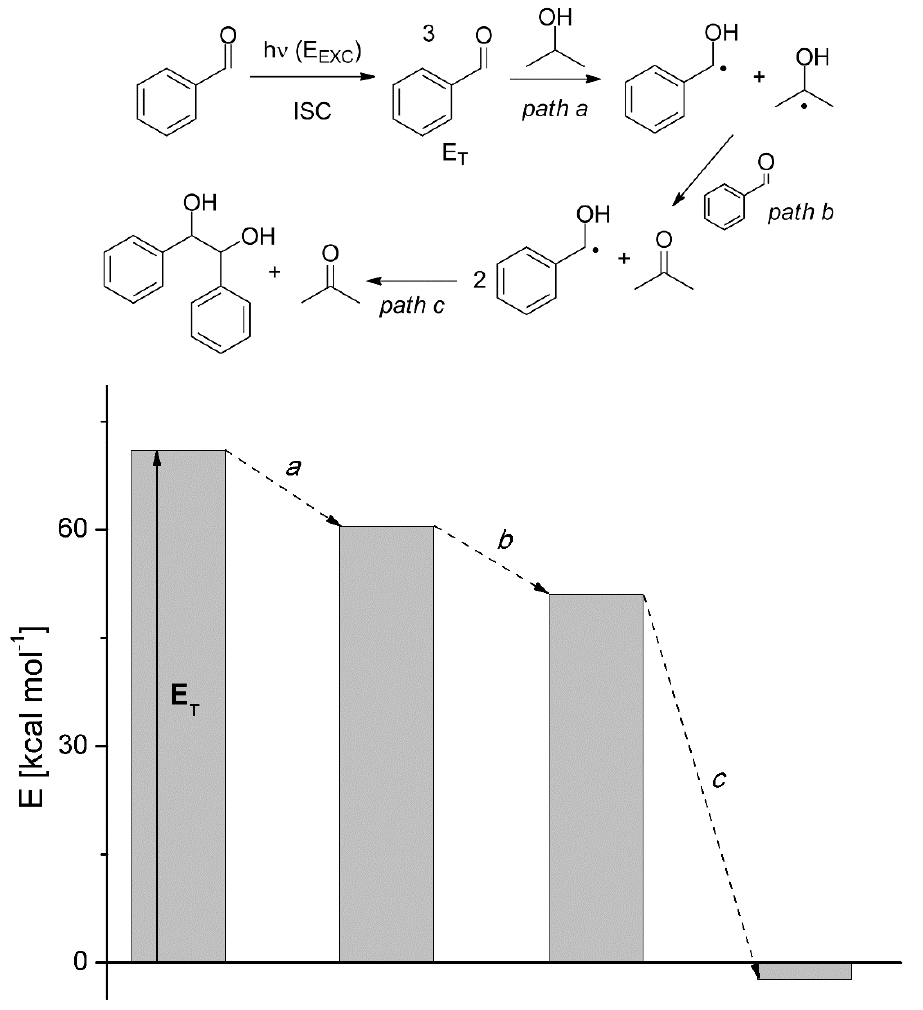
Figure 1. The energetic profile of the steps involved in the reaction reported in Table 1, entry 3. Adapted from Ref.